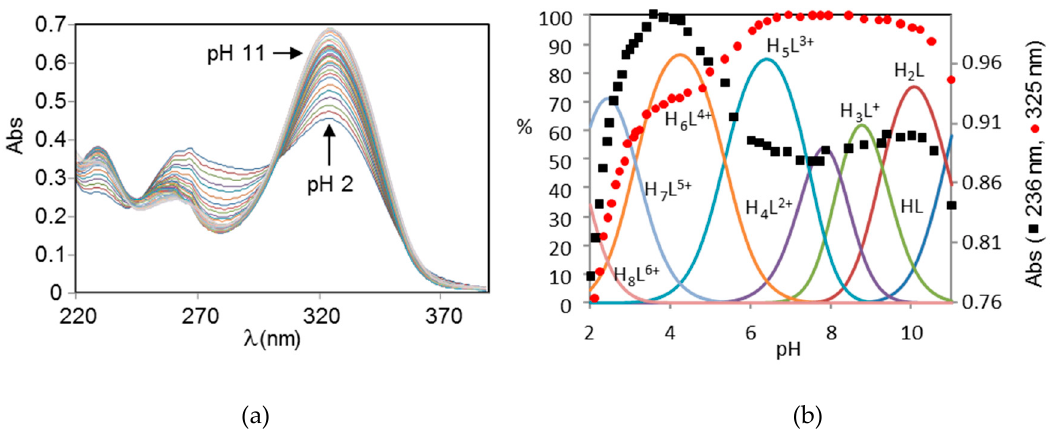
Figure 4. ( a ) UV spectra of H 2 L at different pH values. ( b ) Variation with pH of the 236 nm and 325 nm normalized absorbances of H 2 L superimposed to the distribution diagrams of the species formed.